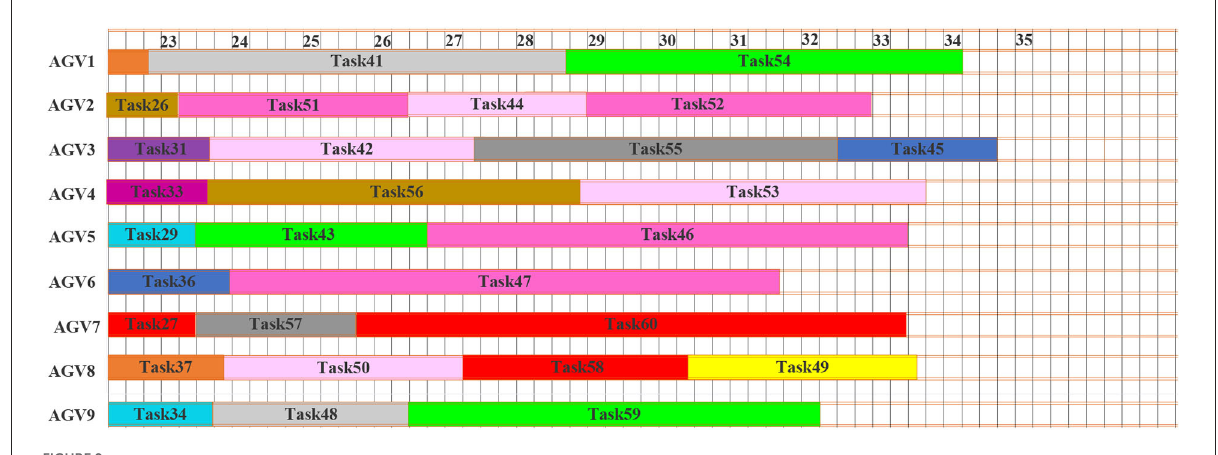
FIGURE9 Gantt chart for dynamic scheduling 3.